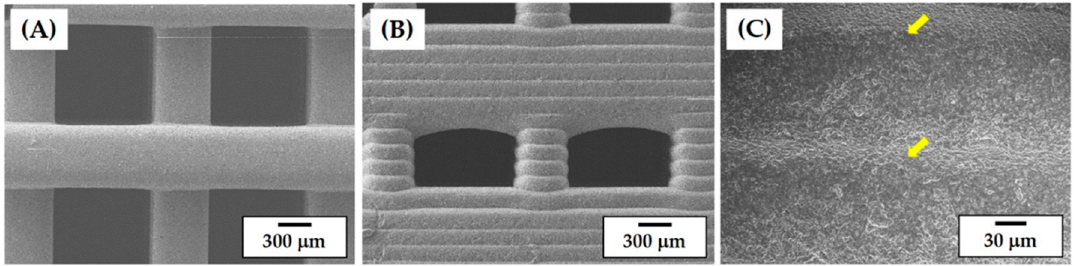
Figure 10. Representative FE-SEM images of the porous CaP scaffolds showing the surface morphologies of ( A ) the top-view and side-views ( B ) at low and ( C ) at high